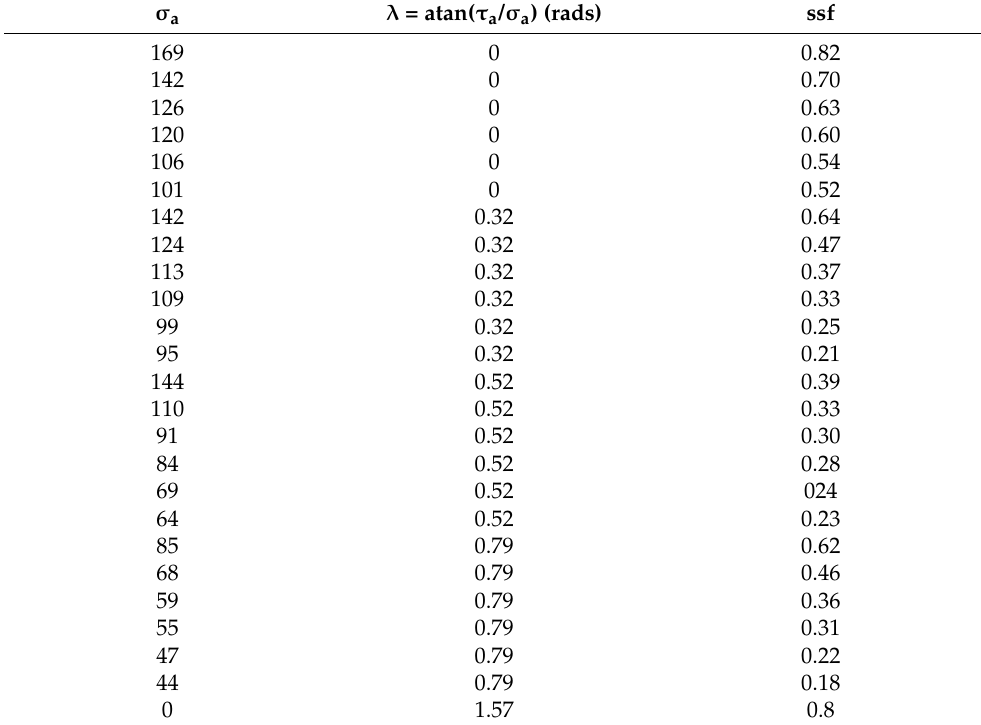
Table 9. ssf results for all loading